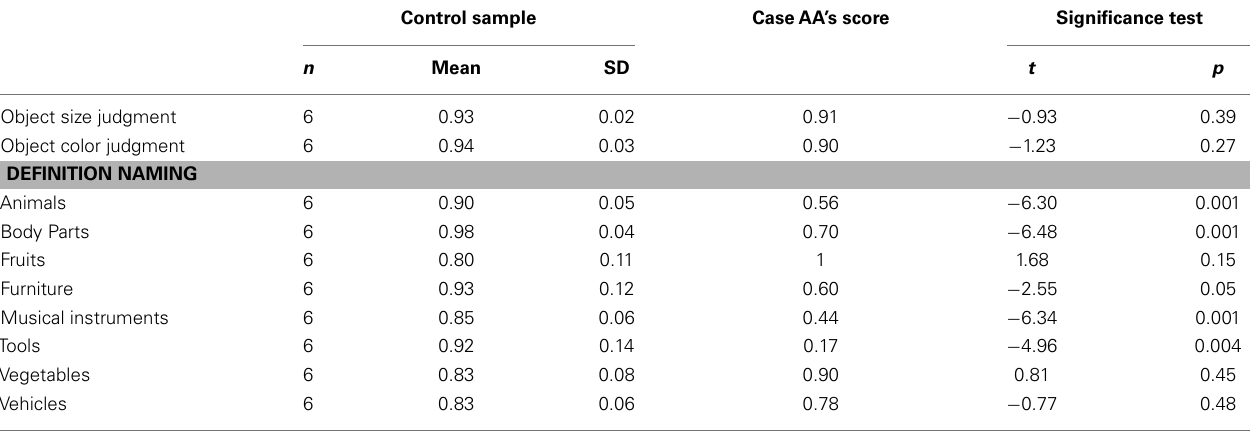
Table 4 | Form-,and color-related object